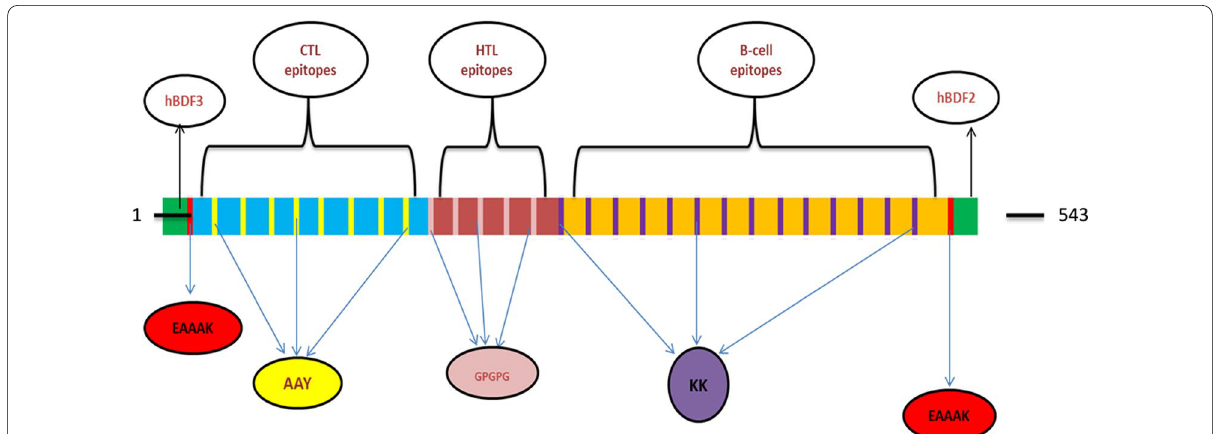
Fig. 1 Schematic specifications of the structure of a 543-amino-acid-long multi-epitope vaccine. Adjuvant with EAAAK linker is added to the beginning and end of the structure, and CTL, HTL and B cell epitopes are connected with AAY, GPGPG and KK linkers,